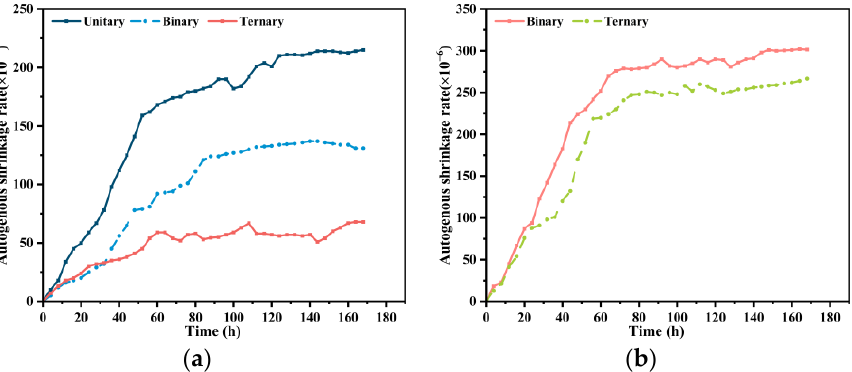
Figure 7. Effect of the mineral blending system on the autogenous shrinkage of PMJC. ( a ) PMJC12, PMJC14, and PMJC15. ( b ) PMJC17 and PMJC18.